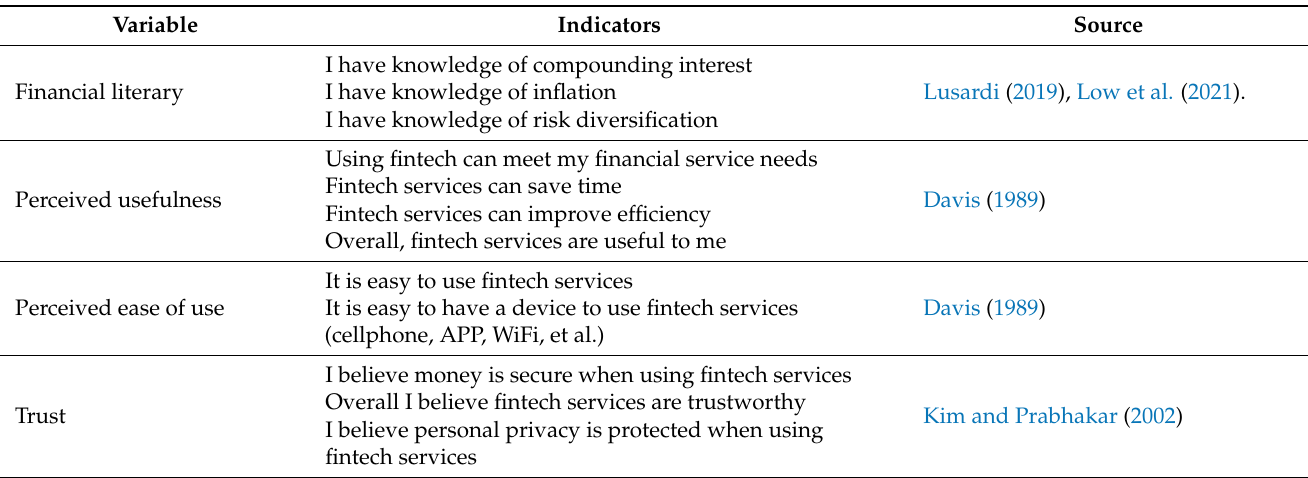
Figure 3. Research framework. Table 2. Measurement instrument.